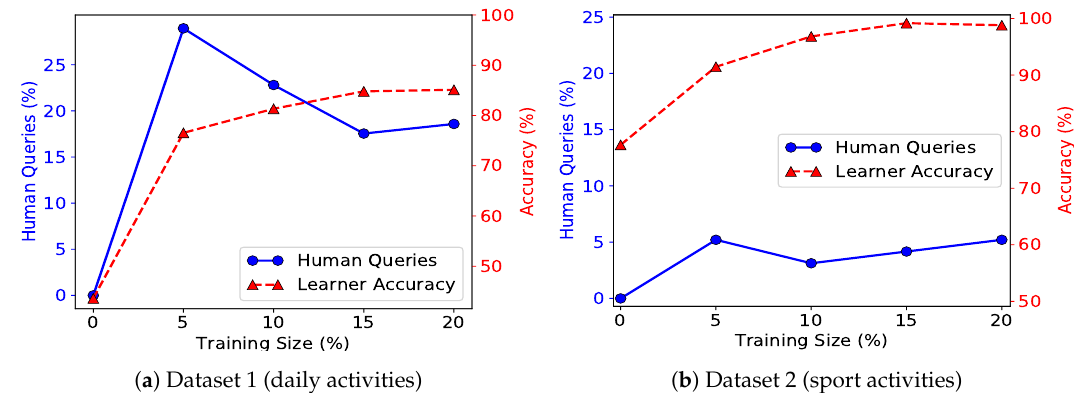
Figure 8. Total number of queries (active training data) versus number of human queries (left axis) and activity recognition accuracy (right axix). Subfigure ( a ) shows results for the daily activities dataset, and subfigure ( b ) shows results for the sport activities dataset.